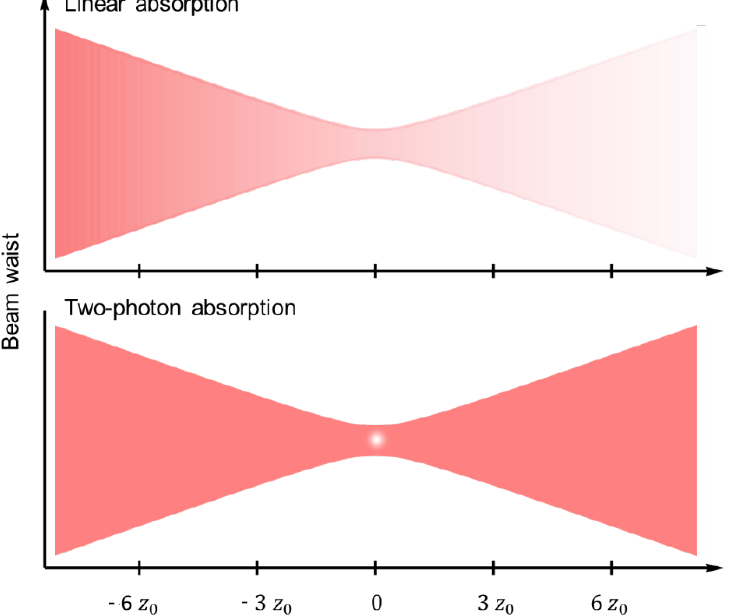
-- Figure 2. Attenuation of a focused laser beam prompted by the absorption of one (above) and two (below) photons. The white color indicates attenuation. The horizontal axis is given in units of the confocal parameter ( z 0 ): the distance from the focal plane at which the beam waist increases by a √ factor of 2. Reprinted with permission [40]. Licensed under a Creative Commons Attribution 4.0 International